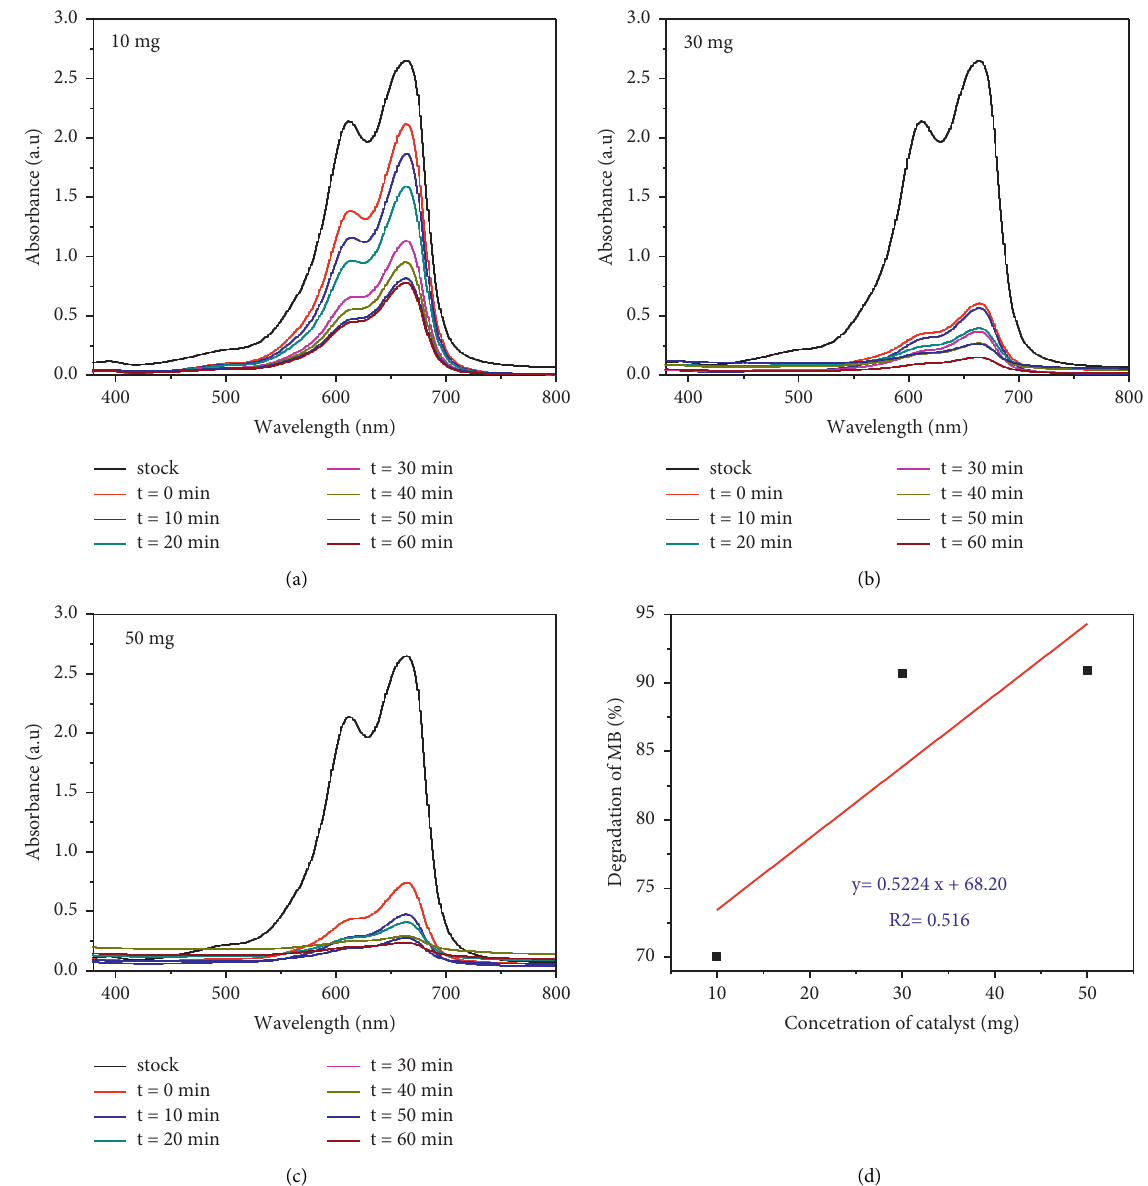
Figure 13: Effect of Citrus sinensis peel extract mediated synthesized TiO degradation of